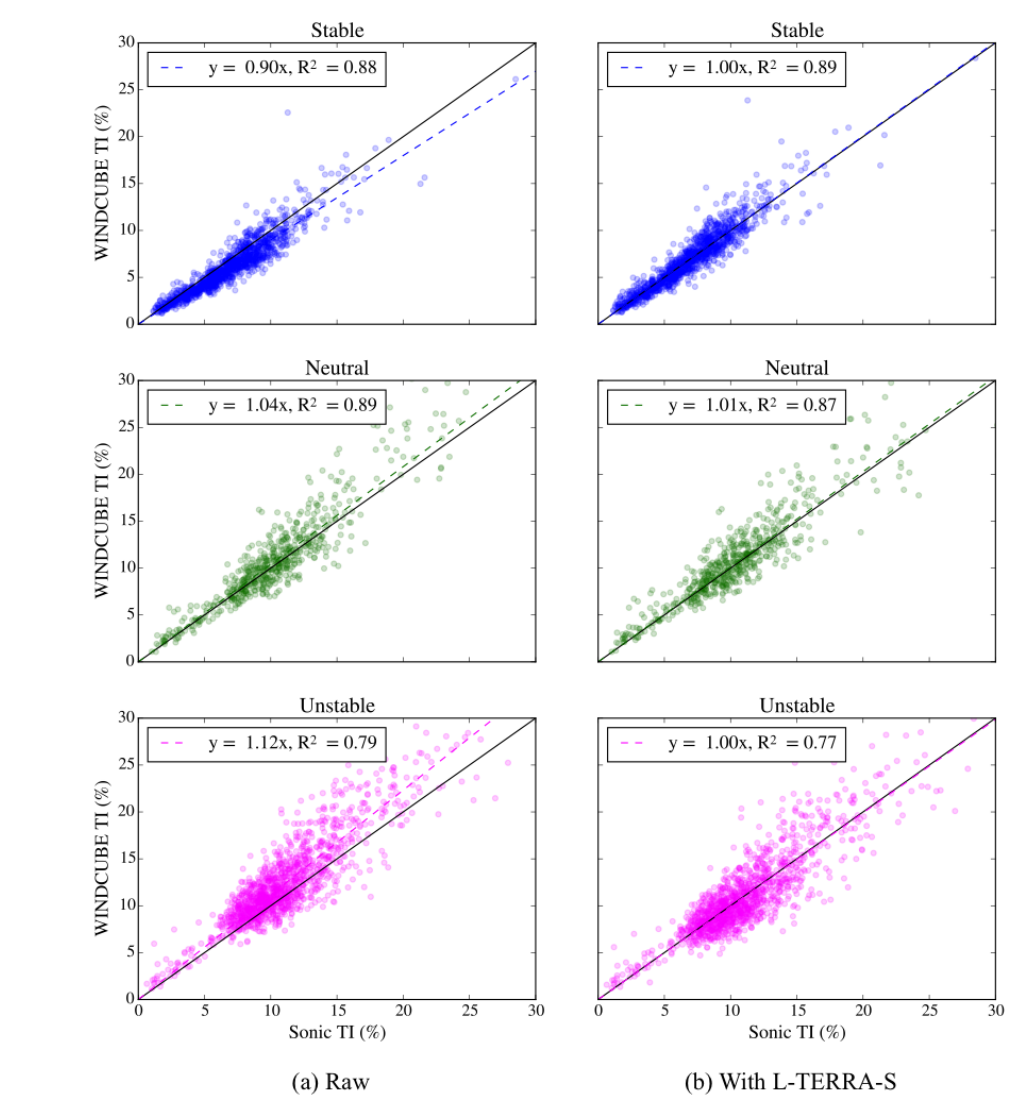
Figure 4. Scatterplots of met tower vs. WC TI for data from 60m measurement height at the ARM site (a) before and (b) after L-TERRA-S has been applied. The 1:1 line and regression lines are shown for reference, and regression line statistics are shown in figure